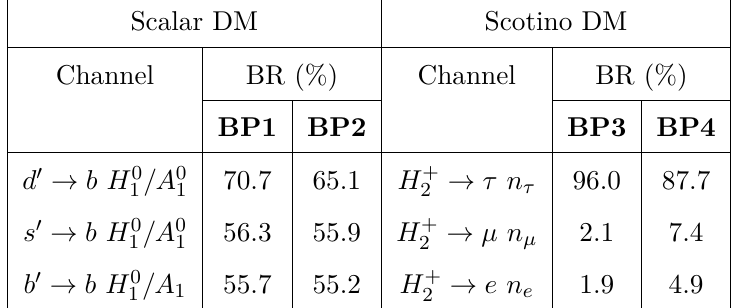
Table 9 . Branching fractions of the exotic quark decay to b quark, and the charged scalar to the leptonic channels, relevant for the four different BP ’s considered.